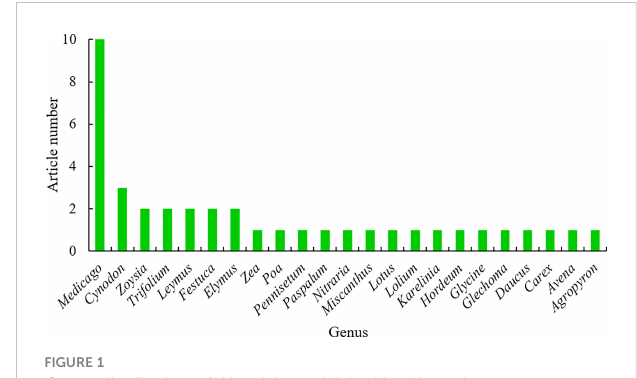
FIGURE 1 Genus distribution of 41 articles published in this